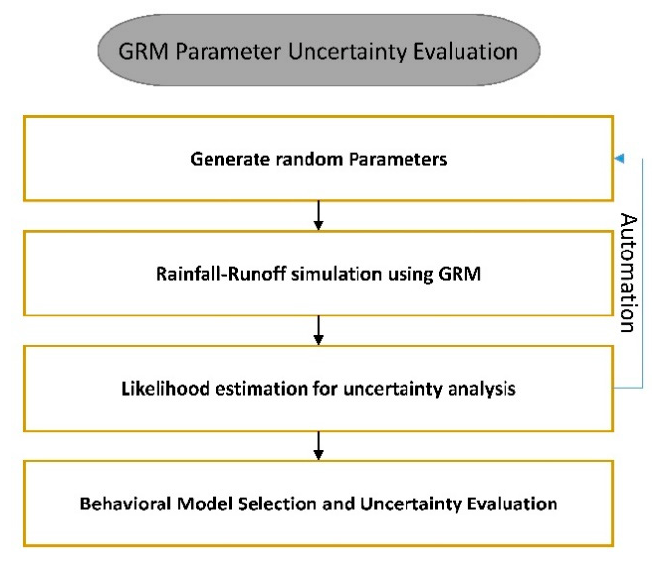
Figure 4. GRM parameter uncertainty estimation method.